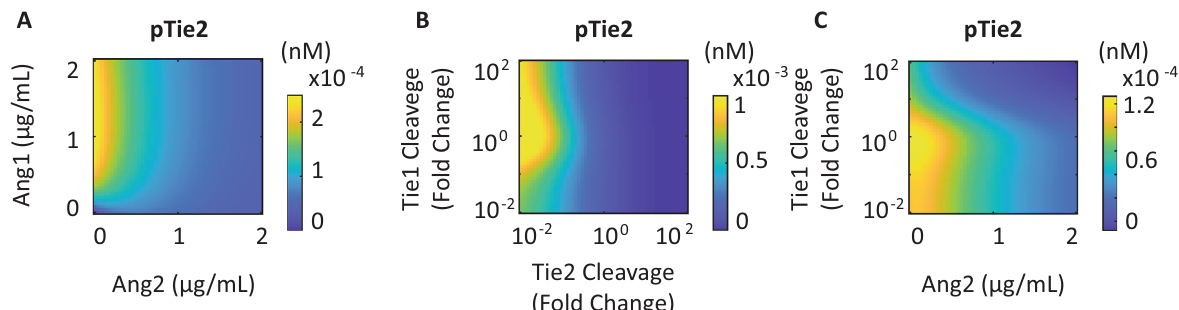
Fig. 5 Molecular concentration ratios of ligands and receptors modulate the activity of Tie2. A Tie2 activation is modulated by the concentration of Ang1 and Ang2. B Extracellular domain cleavage rates of Tie1 and Tie2 affect Tie2 activity by modulating the molecular ratio of Tie1:Tie2. C Tie1 cleavage potentiates Ang2 ’ s antagonistic effect, leading to a low level of Tie2